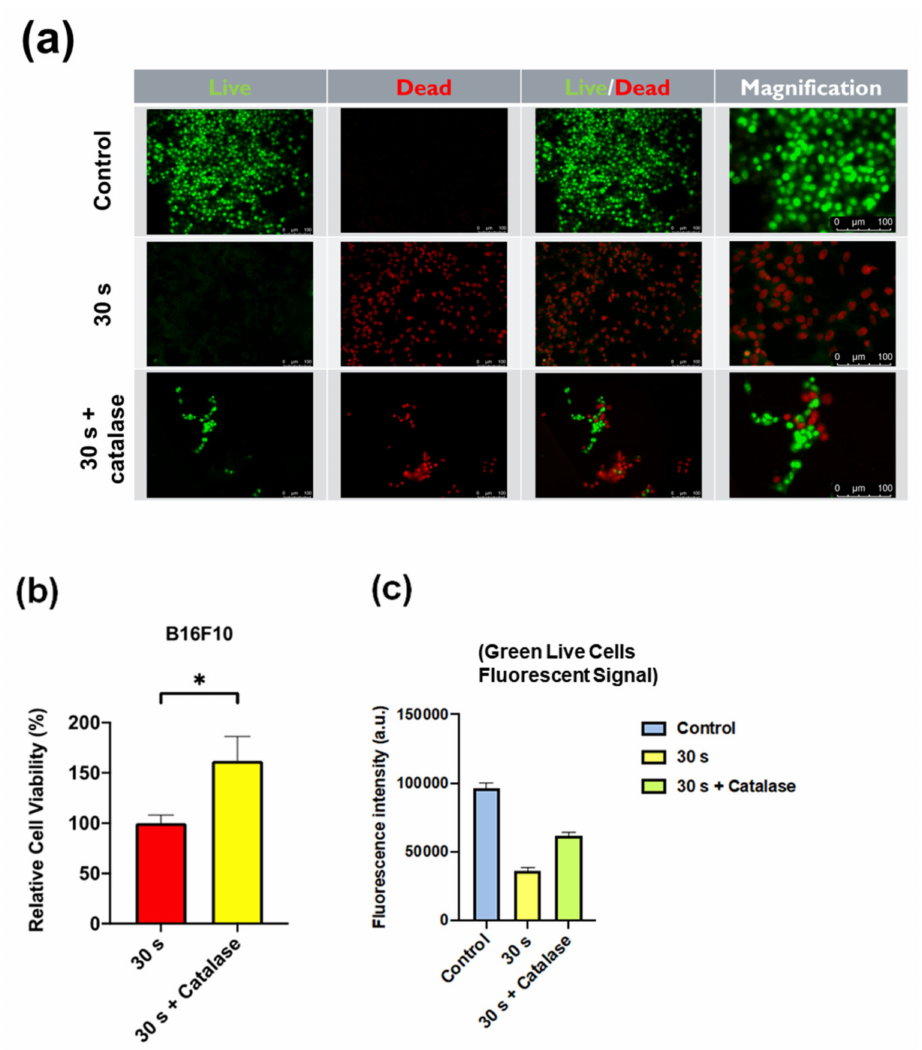
Figure 6. ( a ) Fluorescence image of B16F10 cells treated with transferred cold atmospheric plasma (CAP) after 30 s without and with CAT. Green fluorescence represents live cells, while red fluorescence represents dead cells. ( b ) Cell viability (MTT) after 30 s of treatment without and with CAT. Cell viability was calculated with normalizing the survival of the treated cells group (transferred CAP 30 s) as 100%. ( c ) Fluorescence intensity after 30 s of treatment without and with CAT (green alive cell fluorescent signals). (* p < 0.05) Control: B16F10 cells plus fluorescent